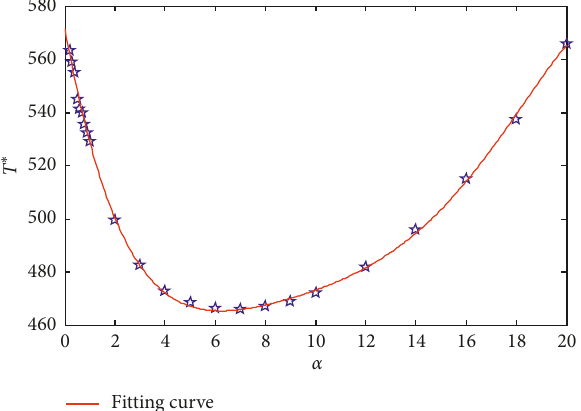
1: (a) α 1–5 and (b) α (cid:31) >